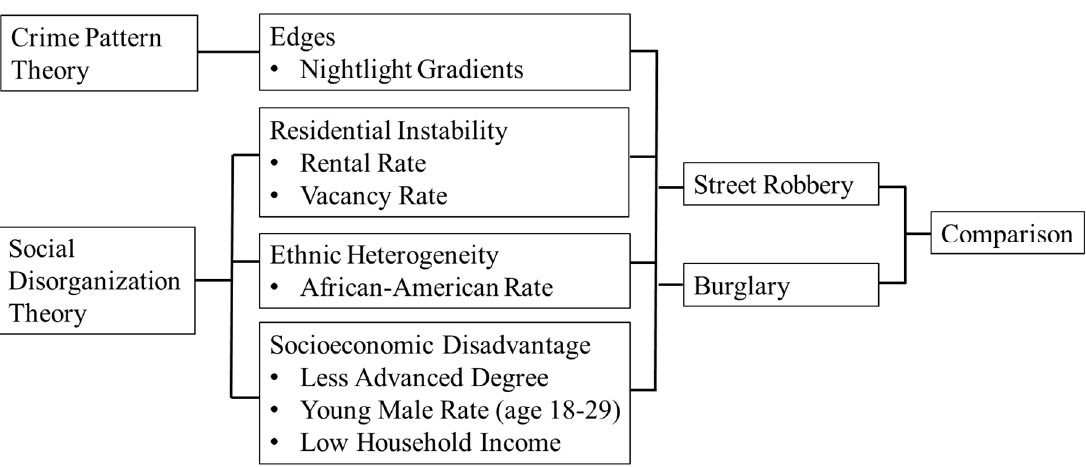
Figure 2. The relationship between the tract environment and street robbery/burglary.